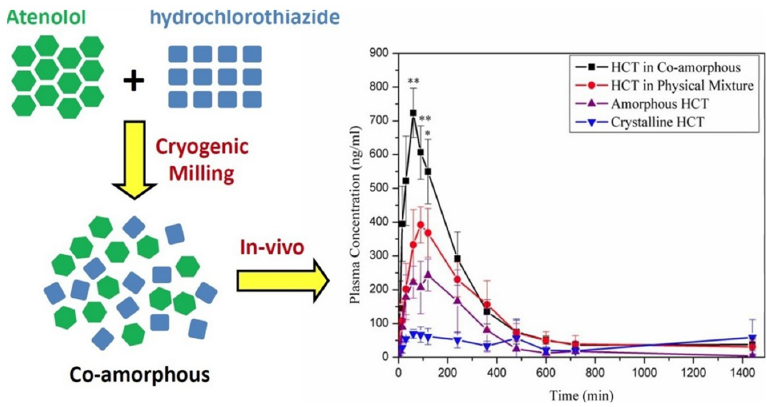
Figure 6. Improved concentration in the plasma of the co-amorphous hydrochlorothiazide (HCT) [38].